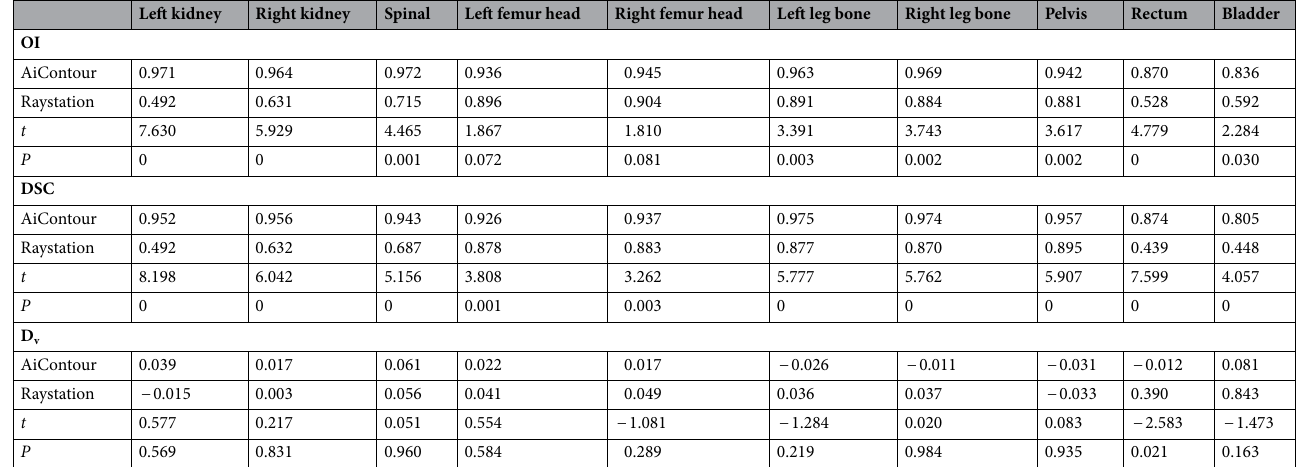
Table 1. Comparison of OI and DSC for OAR automatic delineation of rectal cancer by two